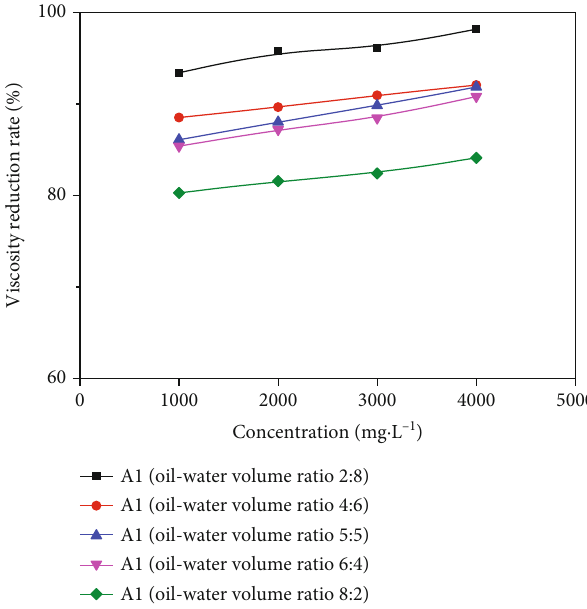
Figure 7: The viscosity reduction rate of viscosity reducing surfactant A1 at di ff erent oil-water volume ratios.